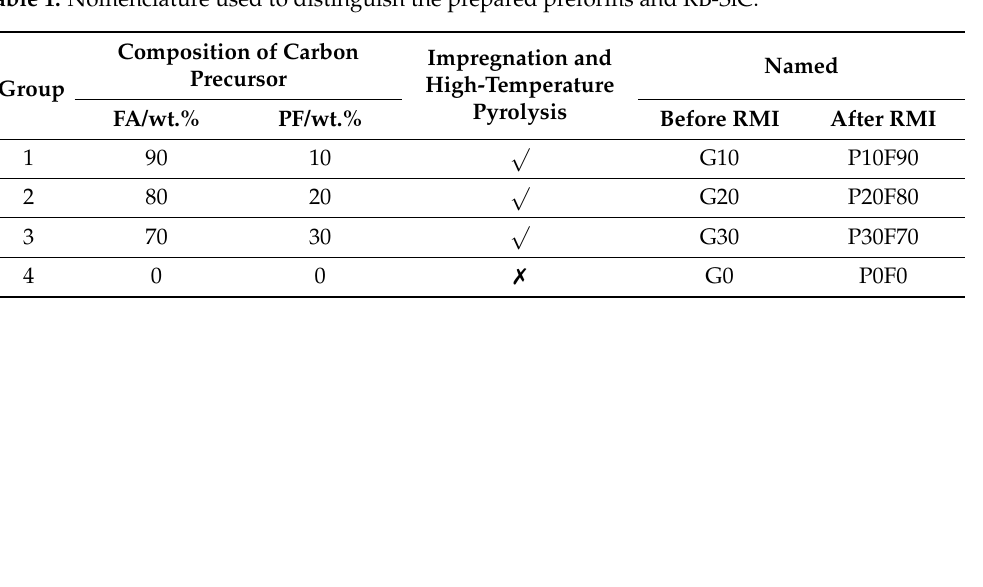
Table 1. Nomenclature used to distinguish the prepared preforms and